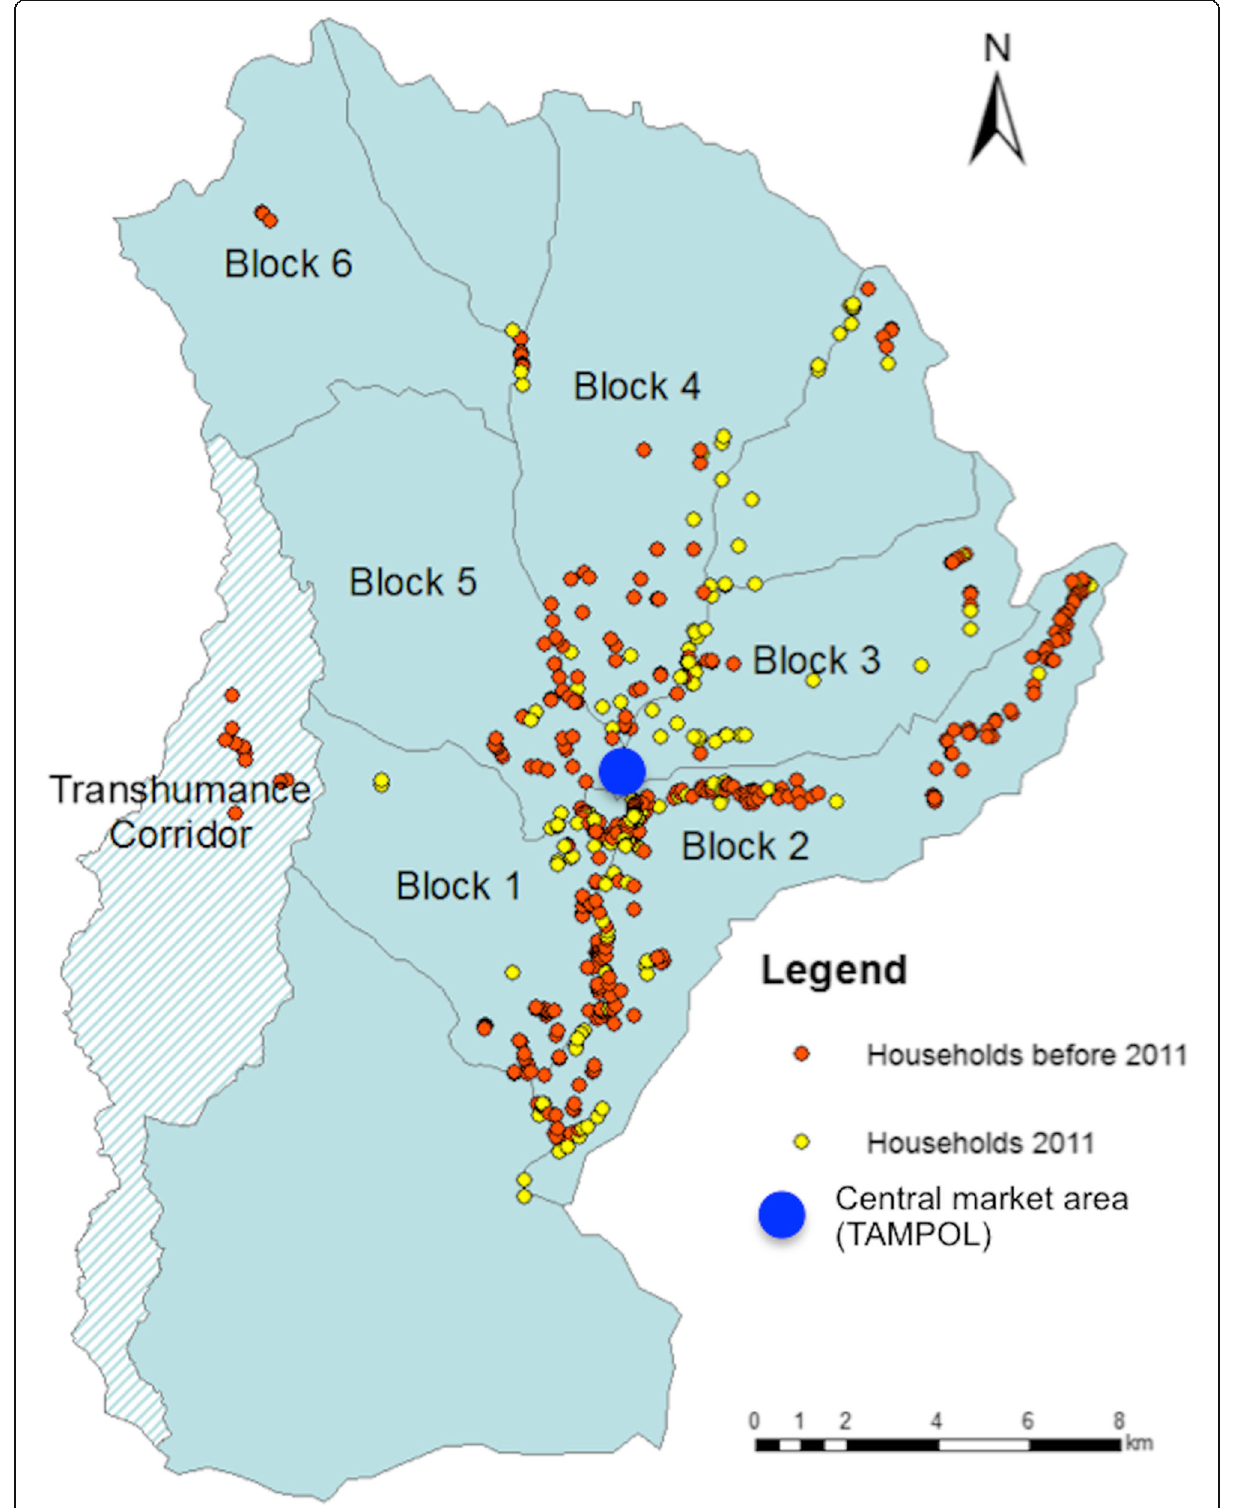
Figure 1 Geographical location of new immigrant (yellow) and established resident (red) households in June